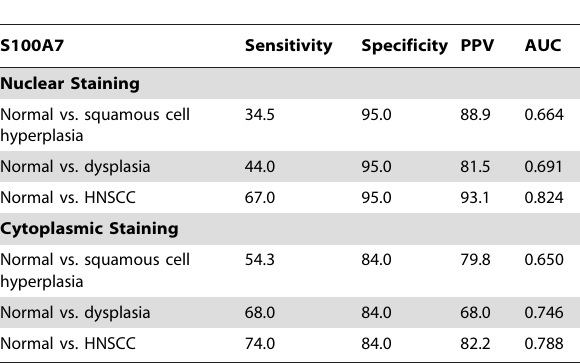
Table 2. Biomarker Analysis of S100A7 (Nuclear/Cytoplasmic) In Oral